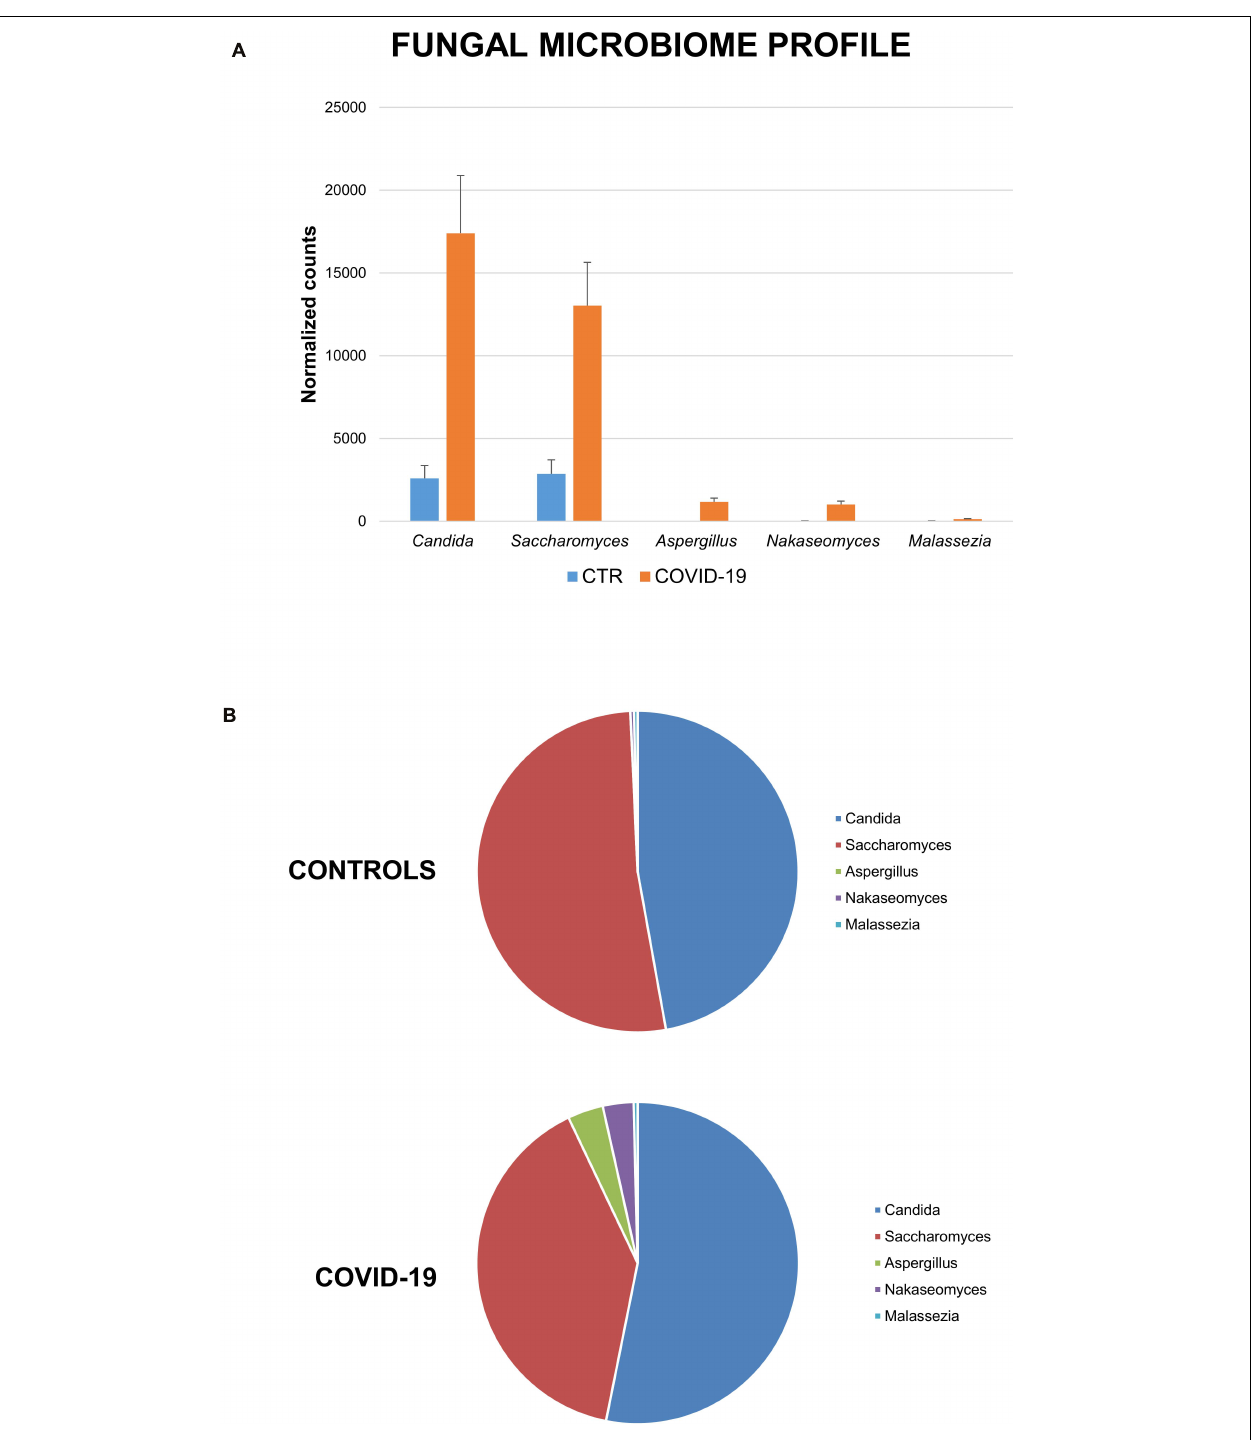
presence of Enterococcus and Enterobacter genera in COVID- 19 patients suggests that they might be a microbial marker of susceptibility for SARS-CoV-2 infection. Even more interesting,